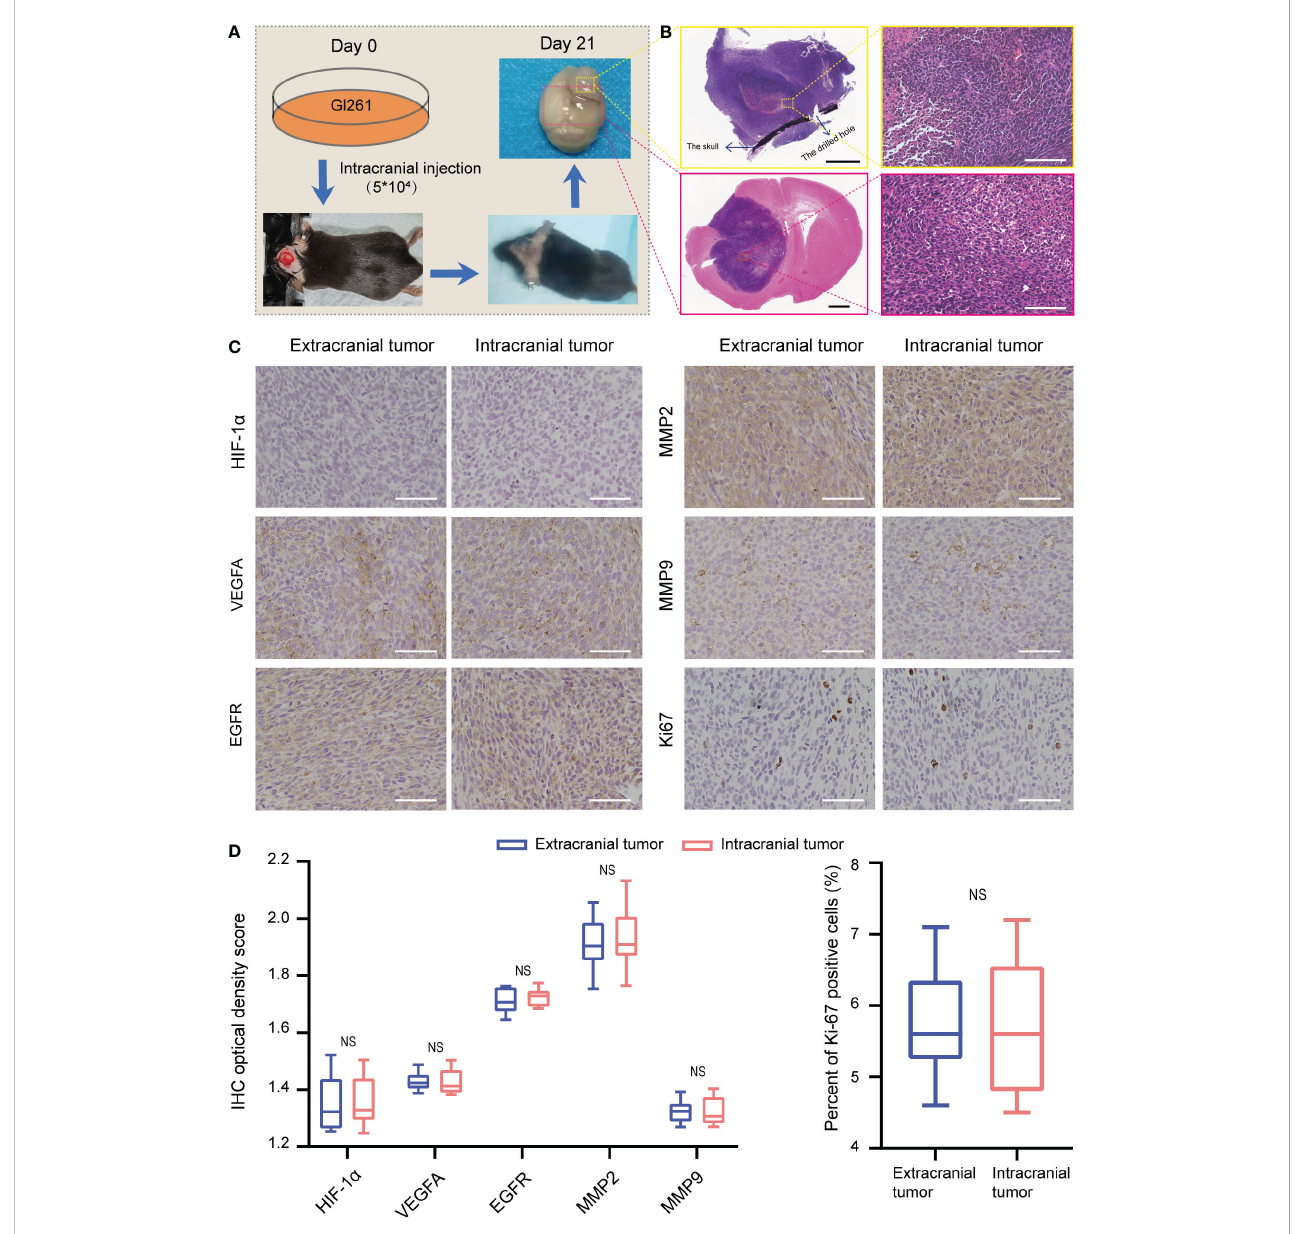
FIGURE 3 Construction of the mouse model and immunohistochemistry analysis. (A) The fl owchart shows the process of creating the glioma mouse model. (B) Hematoxylin and eosin stains of extracranial tumor and intracranial tumor in mouse. Black scaler bar = 1 mm, white scale bar = 100 m m. (C, D) Immunohistochemistry analysis of the extracranial tumor and intracranial tumor in mouse. Scale bar = 100 m m. NS, not signi fi